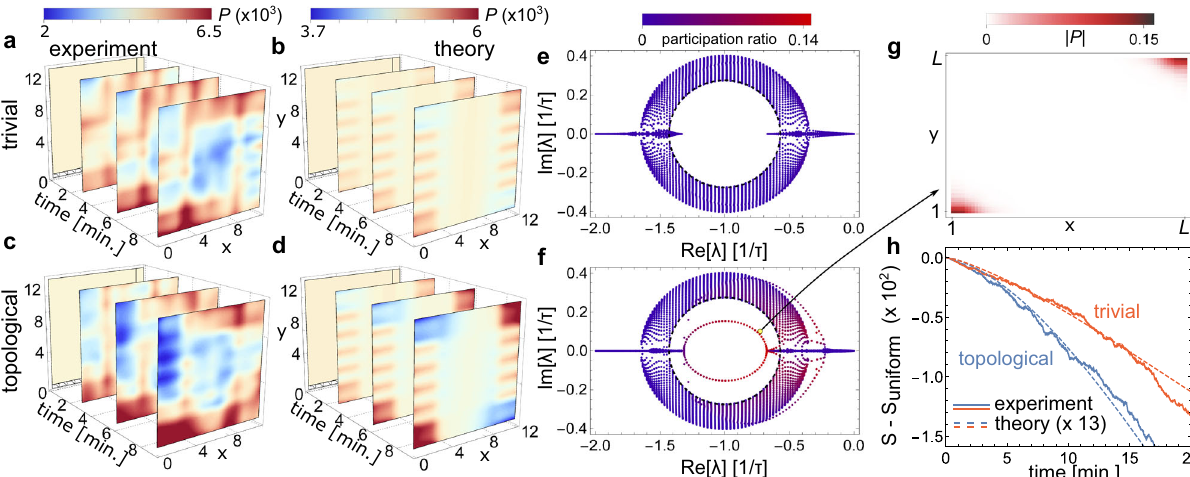
Fig. 4 Second-order non-Hermitian skin effect of the active particles. a – d We compare the distribution of particles in the trivial ( a , c ) and topological ( b , d ) devices with ( L x , L y ) = (13, 14), observed experimentally ( a , b ) and predicted theoretically ( c , d ). We observe that more particles locate on the top right and bottom left corners. e , f Parametric representation of the real and imaginary parts of the spectrum of normal modes for the model of the trivial ( e ) and topological ( f ) devices with ( L x , L y ) = ( L , L ) = (70, 70), colored with the participation ratio of each normal mode ∑ σ ij ∣ P σ ij ∣ 4 , which is small for a delocalized mode. The gap in the periodic band structure is within the dashed circle (see Supplementary Discussion 1). The number of localized modes within the point gap is proportional to the size of the device, L , and are localized at the corners as shown in ( g ). h Shannon entropy of the particle distribution over time. The smaller entropy in the topological device is associated with an accumulation of particles at the corners, signaling the second- order non-Hermitian skin effect. The theoretical fi gures match the experimental curves when multiplied by a factor ×13, suggesting that particle jamming, that occurs frequently for higher densities of active particles, contributes to enhance the